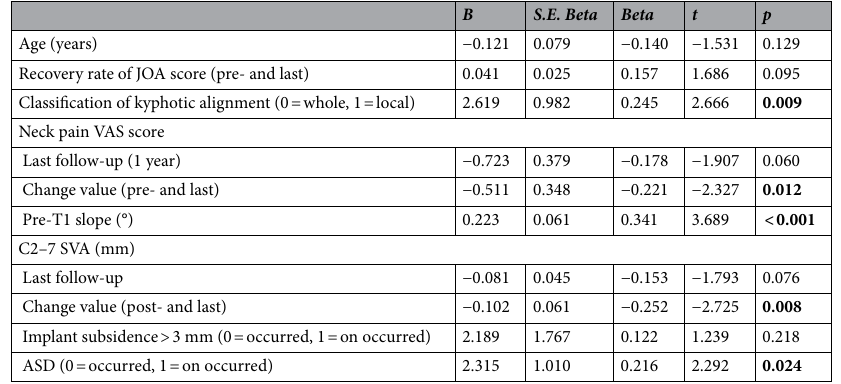
Table 4. Multiple linear regression model for predictive factors of worsening sagittal alignment after operation. JOA Japanese Orthopaedic Association, VAS Visual Analogue Score, T1 thoracic 1, SVA sagittal vertical axis, ASD Adjacent segment degeneration. Significant values are in